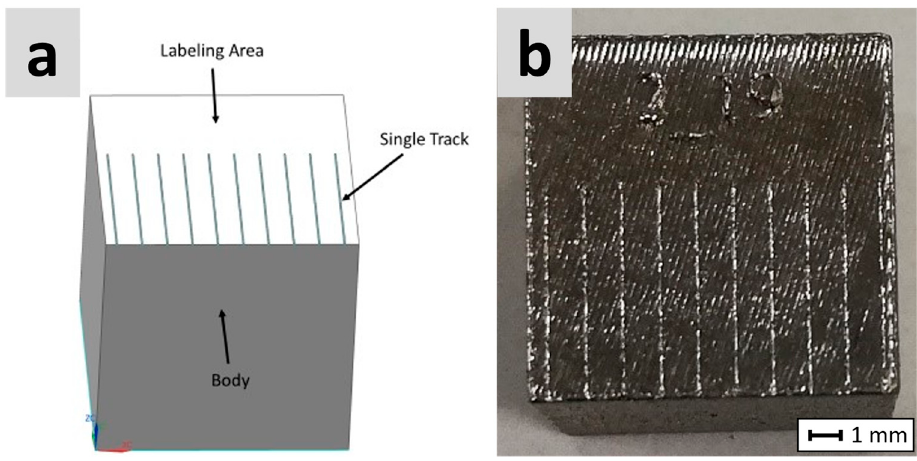
Figure 3. Specimen design: ( a ) CAD model, ( b ) example of the printed specimen.